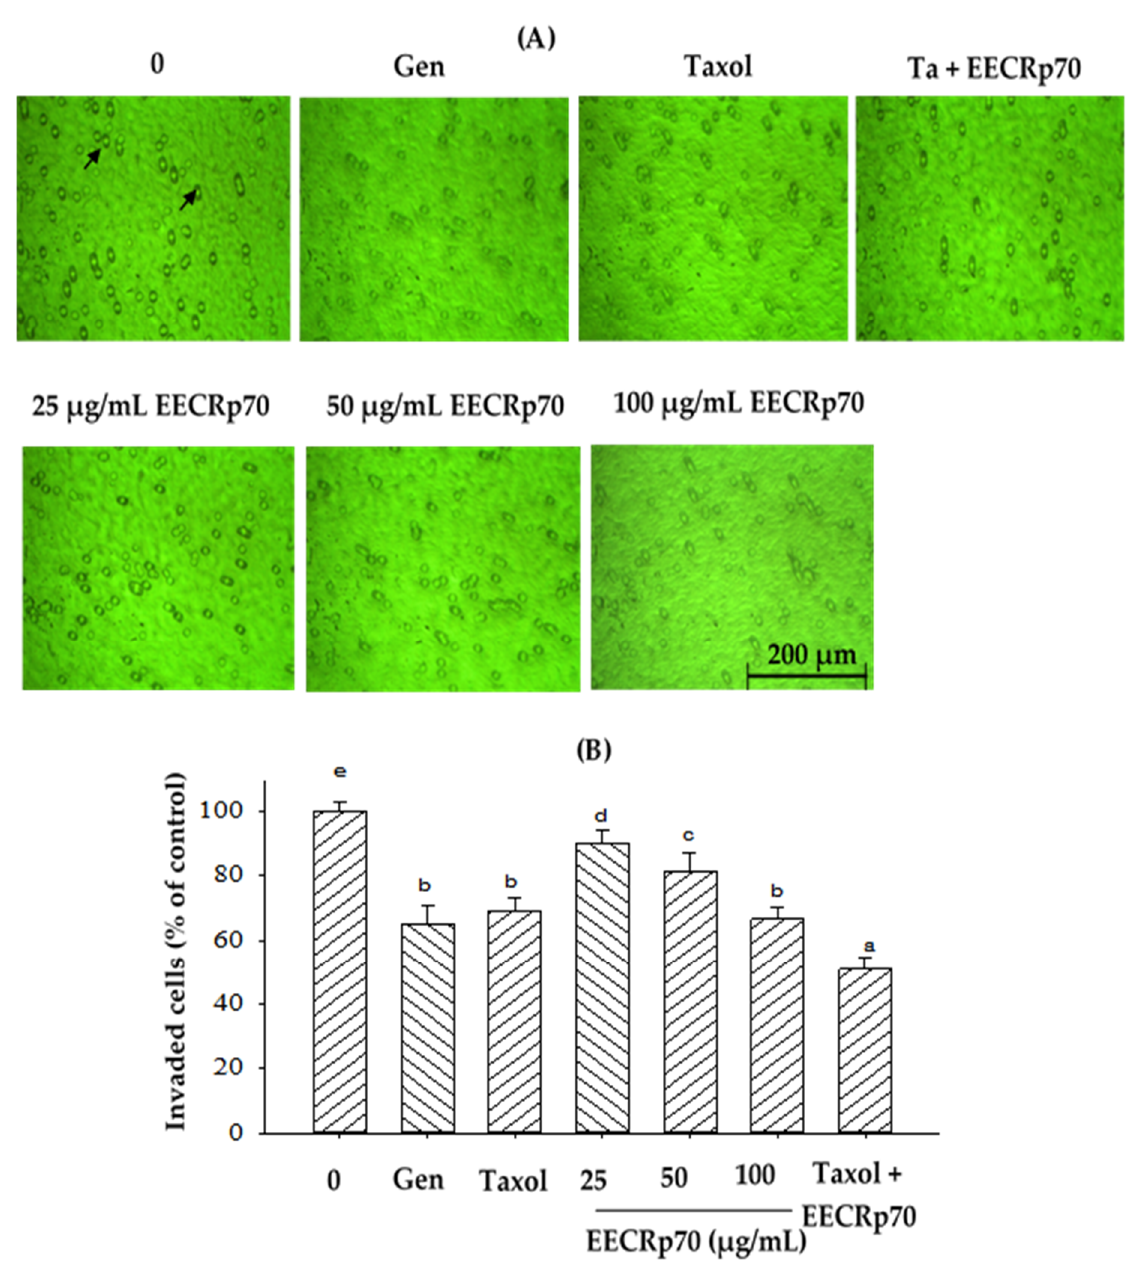
Figure 9. Effects of EECRp70 on a transwell invasion assay in SCC25 cells. ( A ) Photomicrographs and ( B ) percentage of invaded cells. Each upper transwell was pre-coated with Matrigel in cold DMEM/F12 before cells were incubated with 25 µM genistein, 10 nM taxol, 25–100 µg/mL EECRp70, and 10 nM taxol + 25 µg/mL EECRp70 for 24 h and calculated the invasion cells of the transwell. Photomicrographs were obtained using an Inverted Fluorescence Microscope BestScope-7000B (×200 magnification and scale bar 200 µm). For each replicate, cancer cells in six randomly selected fields were determined, counted, and averaged. The arrowhead indicates the invaded cells. Values (mean ± SD) not labeled with a common letter are significantly different ( p < 0.05).